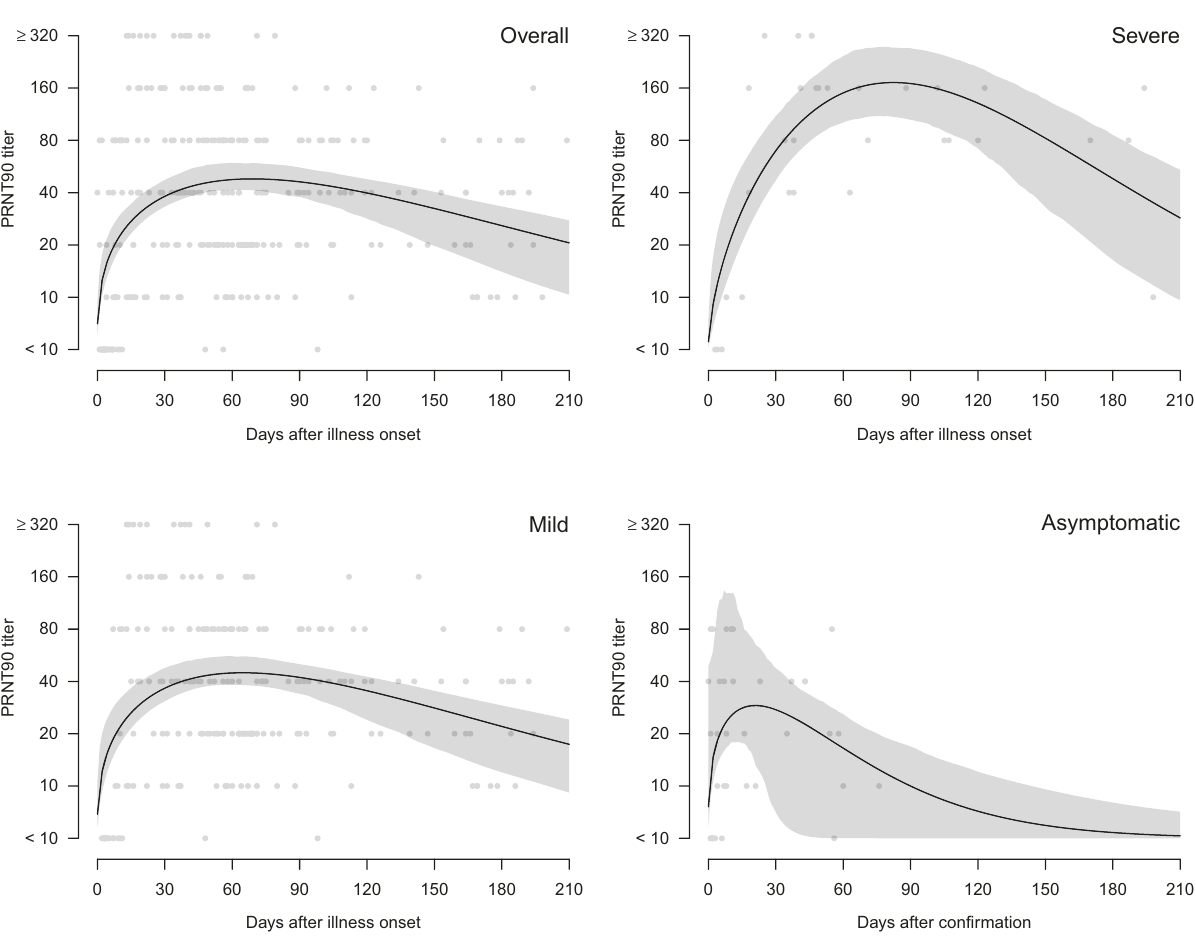
Fig. 1 Antibody responses (PRNT 90 ) in COVID-19 patients by days after illness onset and severity, Hong Kong ( n = 293 samples). The black lines showed the fi tted values and gray areas showed the 95% con fi dence intervals. Neutralization tests were carried out in